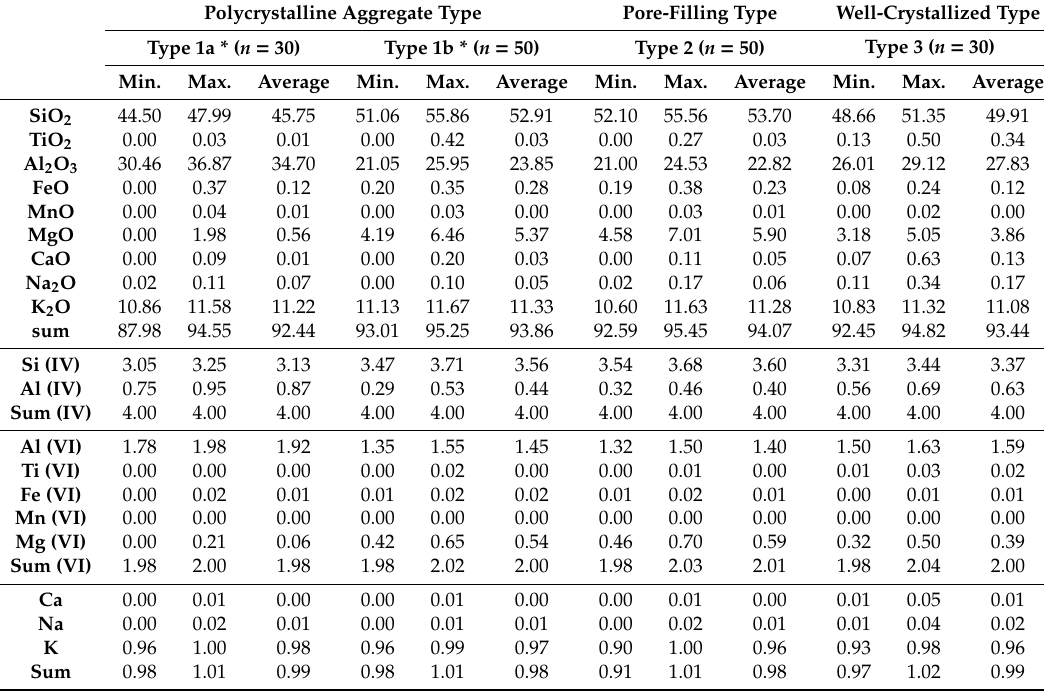
Table 1. Representative electron probe micro analyzer (EPMA) data of the phengites from the Haengmae Formation and structural formulae calculated using 11 oxygens.